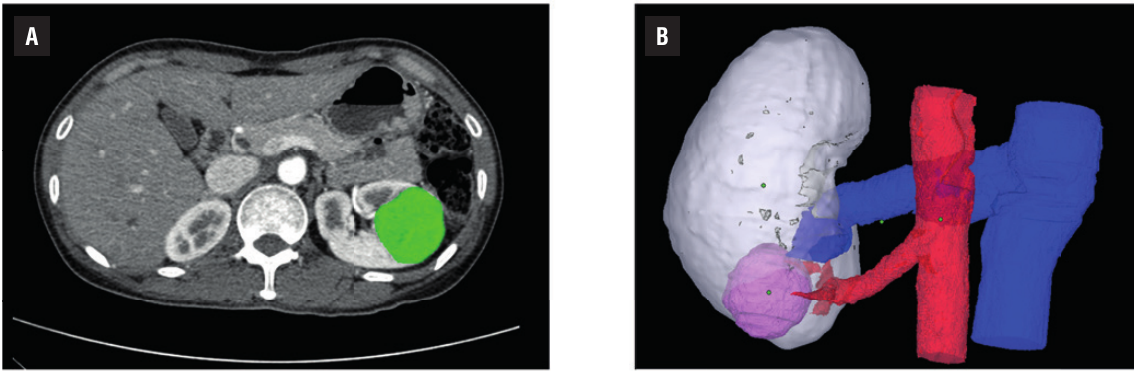
figure 1 - A) preoperative images with additional processing for discrimination of tumor. B) The fi nal 3D rendered images before printing.